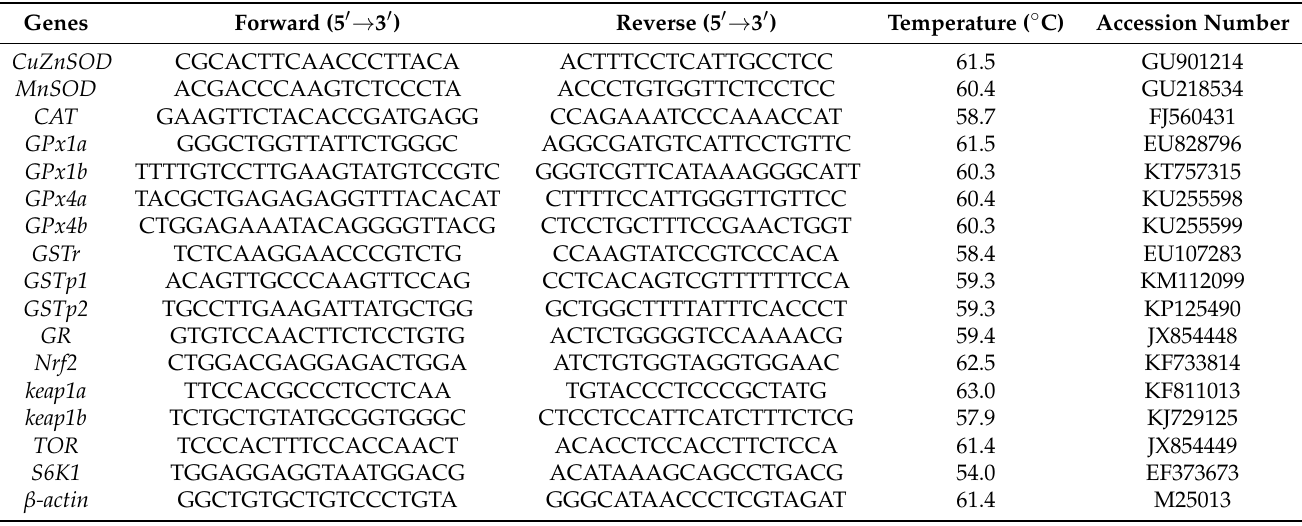
Table 2. Real-time PCR primer